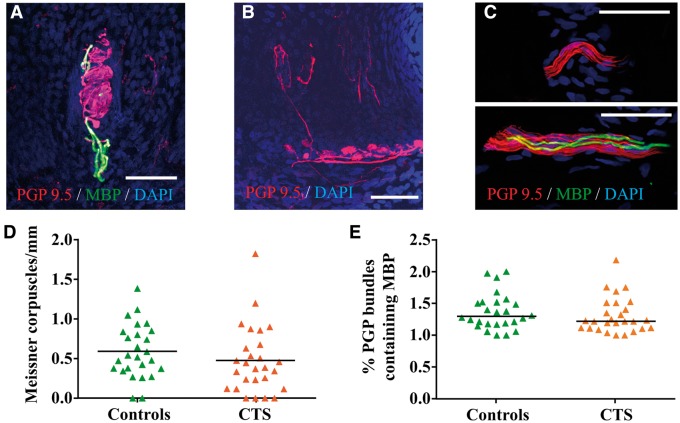
Representative images of dermal histology in 50 µm thick immuno-stained sections. (A) A Meissner corpuscle located in the dermal papilla. The characteristic winding-like structure of the Meissner corpuscle is formed by axons (red, protein gene product, PGP9.5) and it is innervated by a myelinated fibre (green, myelin basic protein, MBP). Nuclei are stained in blue (DAPI). (B) Example of a Merkel cell complex (red, PGP9.5) located at the base of the epidermis and innervated from fibres originating from the subepidermal plexus (bottom). (C) Representative images of the quantified dermal axon bundles containing more than five axons (red, PGP9.5) in the same section. Whereas the bundle on the top only contains unmyelinated fibres, on the bottom is an example of a dermal nerve bundle that contains two myelinated fibres (green, MBP). Calibration of 50 µm applies throughout. (D) Graph shows a comparable amount of Meissner corpuscles per mm epidermis in patients with carpal tunnel syndrome and controls participants. Data are shown as mean and single data points, P = 0.28. (E) Graph shows comparable percentage of dermal PGP bundles containing MBP-positive fibres between patients with carpal tunnel syndrome and control participants. Plot depicts median and single data points, P = 0.38.